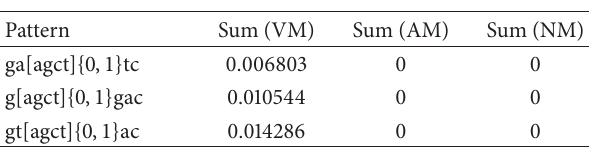
Figure 2: Decision tree created by Weka package. AM is always methylated, NM is never methylated (NM) and (VM) is variably